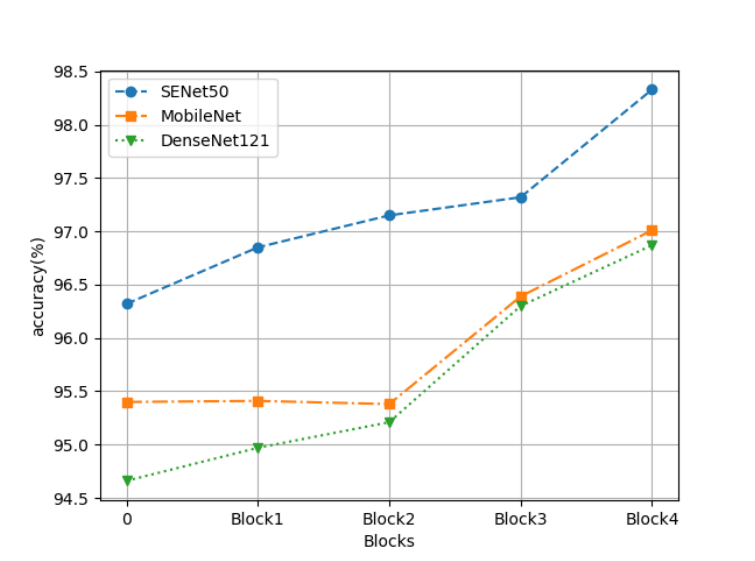
Figure 6. Impact of the number share of CroReLU on accuracy on three deep learning models.